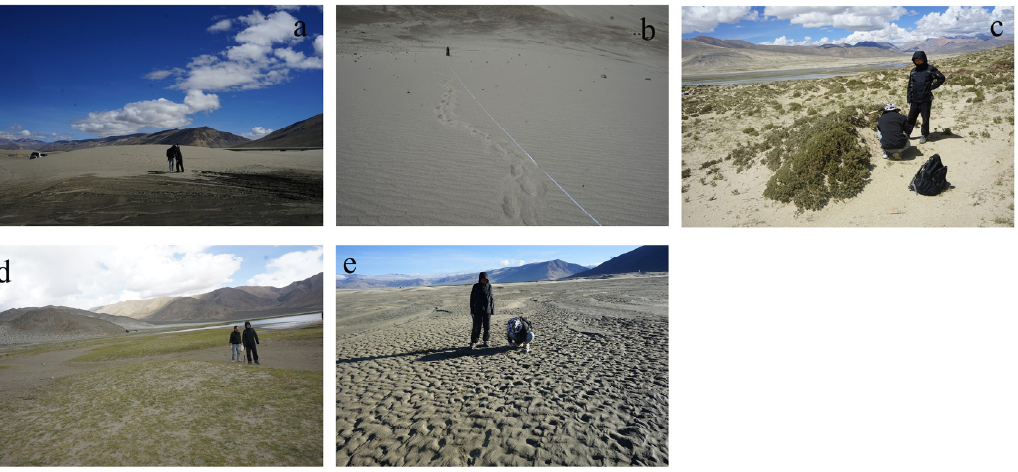
Figure 2. Map of sampling sites: ( a ) is mobile dune, ( b ) is climbing sand sheet, ( c ) is nebkha, ( d ) is lakeshore, and ( e ) is flood plain.